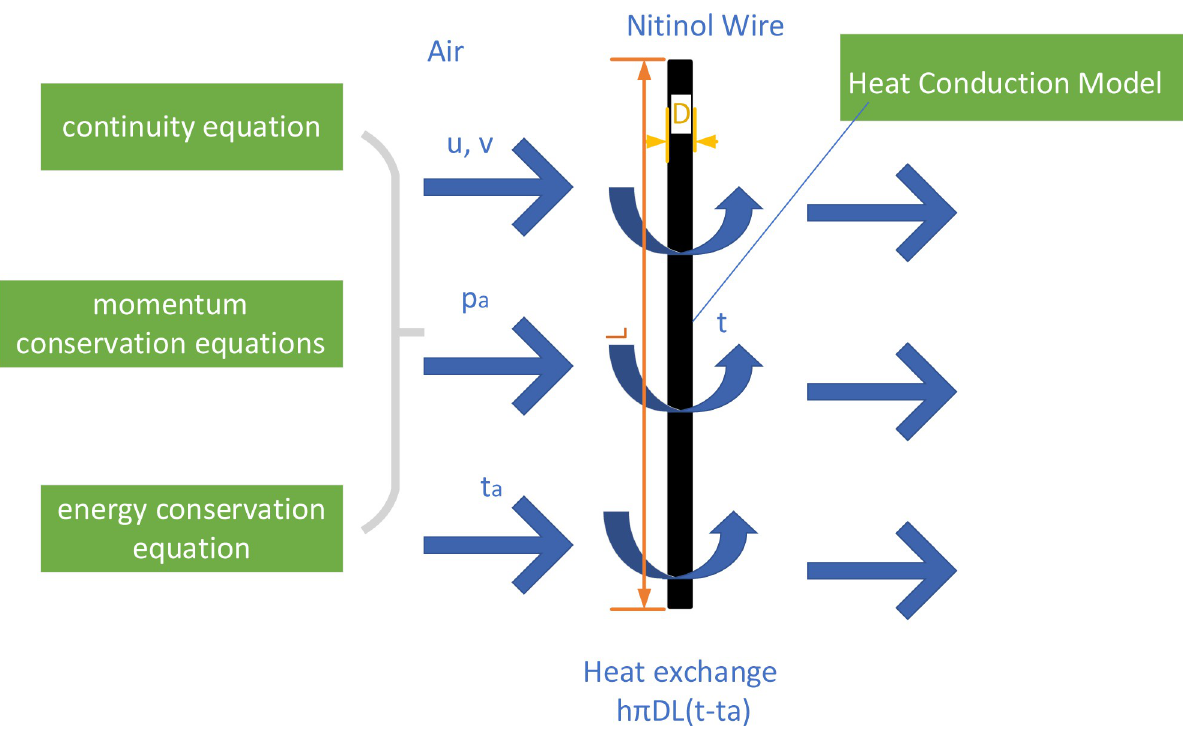
Fig 5. Sketch map of the coupled flow and convective heat transfer